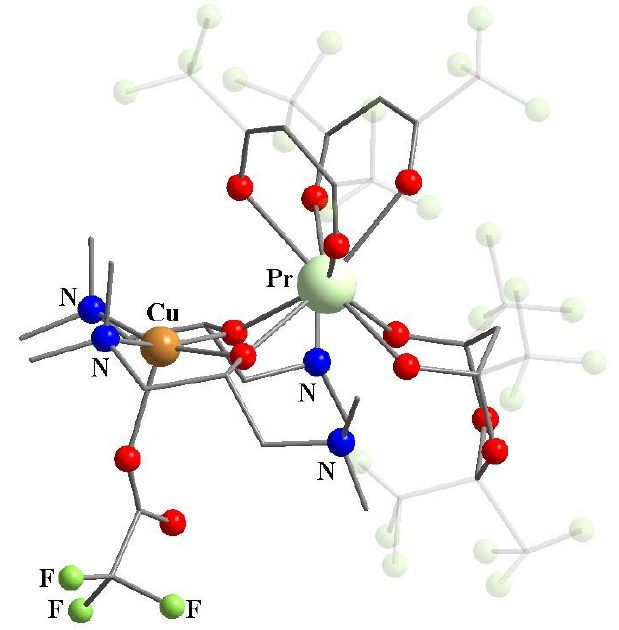
Figure 41. Crystal structure of [Pr(hfac) 2 (CF 3 -diol)Cu(Hbdmap) 2 (tfa)] ( 93 ) [131]. CF 3 groups are transparent for clarity. The cif has been retrieved from CCDC. CCDC number is 1232922.